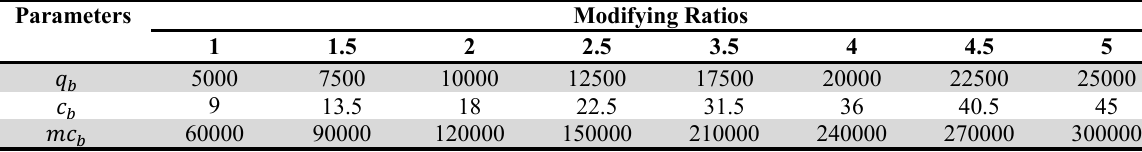
Values of parameters under different capacity ratios Parameters